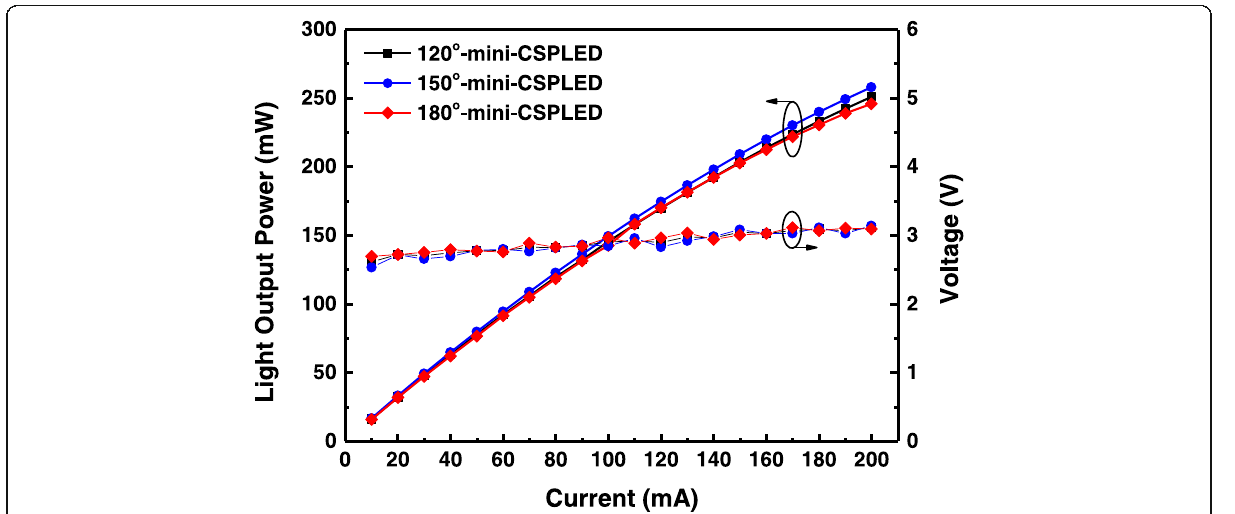
Fig. 4 The L – I – V characteristics of the 120° mini-CSPLED, 150° mini-CSPLED, and 180°